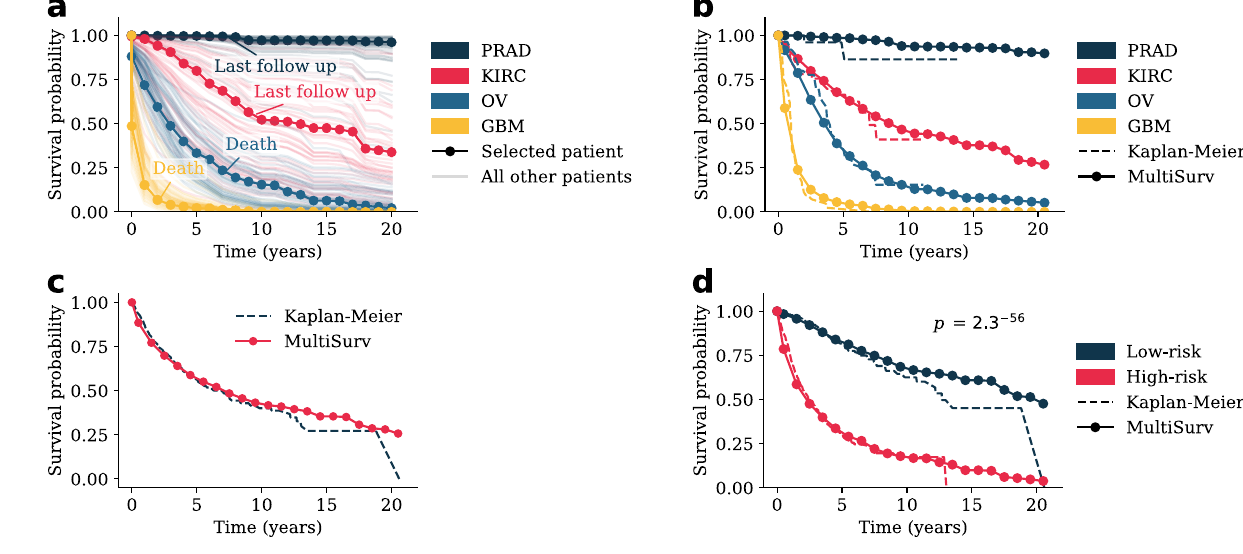
Figure 2. MultiSurv predictions allow construction of accurate survival curves. MultiSurv outputs patient survival predictions for the defined discrete-time follow up intervals. These can then be averaged to obtain group-wide survival predictions. ( a ) Survival curves constructed using Multisurv predictions for each patient in the test dataset diagnosed with one of four selected cancer types. One example patient is highlighted for each cancer type and the corresponding last follow up time point is annotated (as “Last follow up” if the patient is censored or “Death” if it corresponds to patient death). Highlighted patient codes are TCGA-HI-7169 for PRAD, TCGA-B0-5691 for KIRC, TCGA-29-1762 for OV, and TCGA-19-1390 for GBM. ( b ) Survival curves for the four example cancer types in ( a ) compared with Kaplan–Meier estimator outputs. ( c ) Survival curves for all patients in the test dataset compared with the Kaplan–Meier estimator output. ( d ) MultiSurv predictions allow accurate stratification of patient risk groups. Patients were split into low and high-risk groups according to MultiSurv’s first output interval risk prediction using the median value across all patients as the threshold. The two resulting groups have significantly different Kaplan–Meier estimates (log-rank test). The plot shows MultiSurv prediction averages overlayed on the Kaplan–Meier estimators. PRAD prostate adenocarcinoma, KIRC kidney renal clear cell carcinoma, OV ovarian serous cystadenocarcinoma, GBM glioblastoma